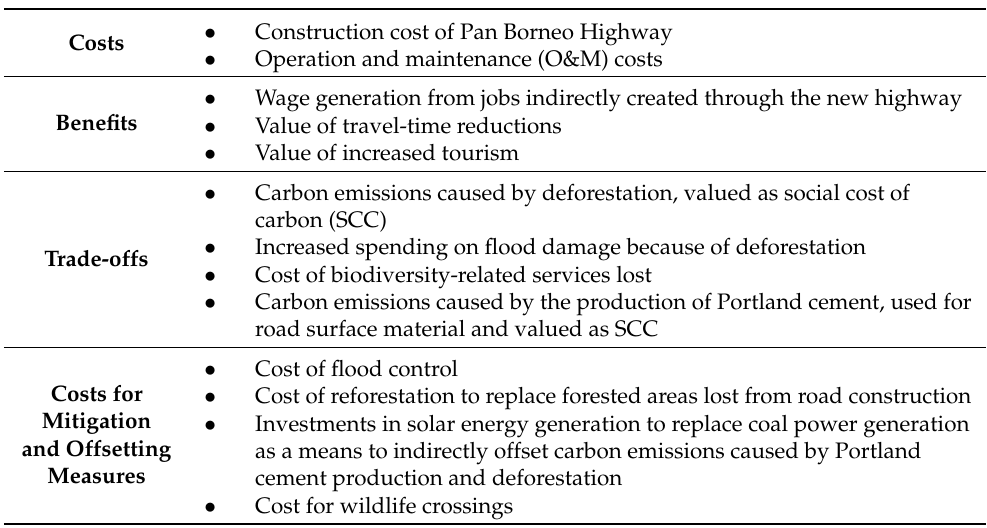
Table 2. Factors evaluated in the SAVi simulation for the Borneo case